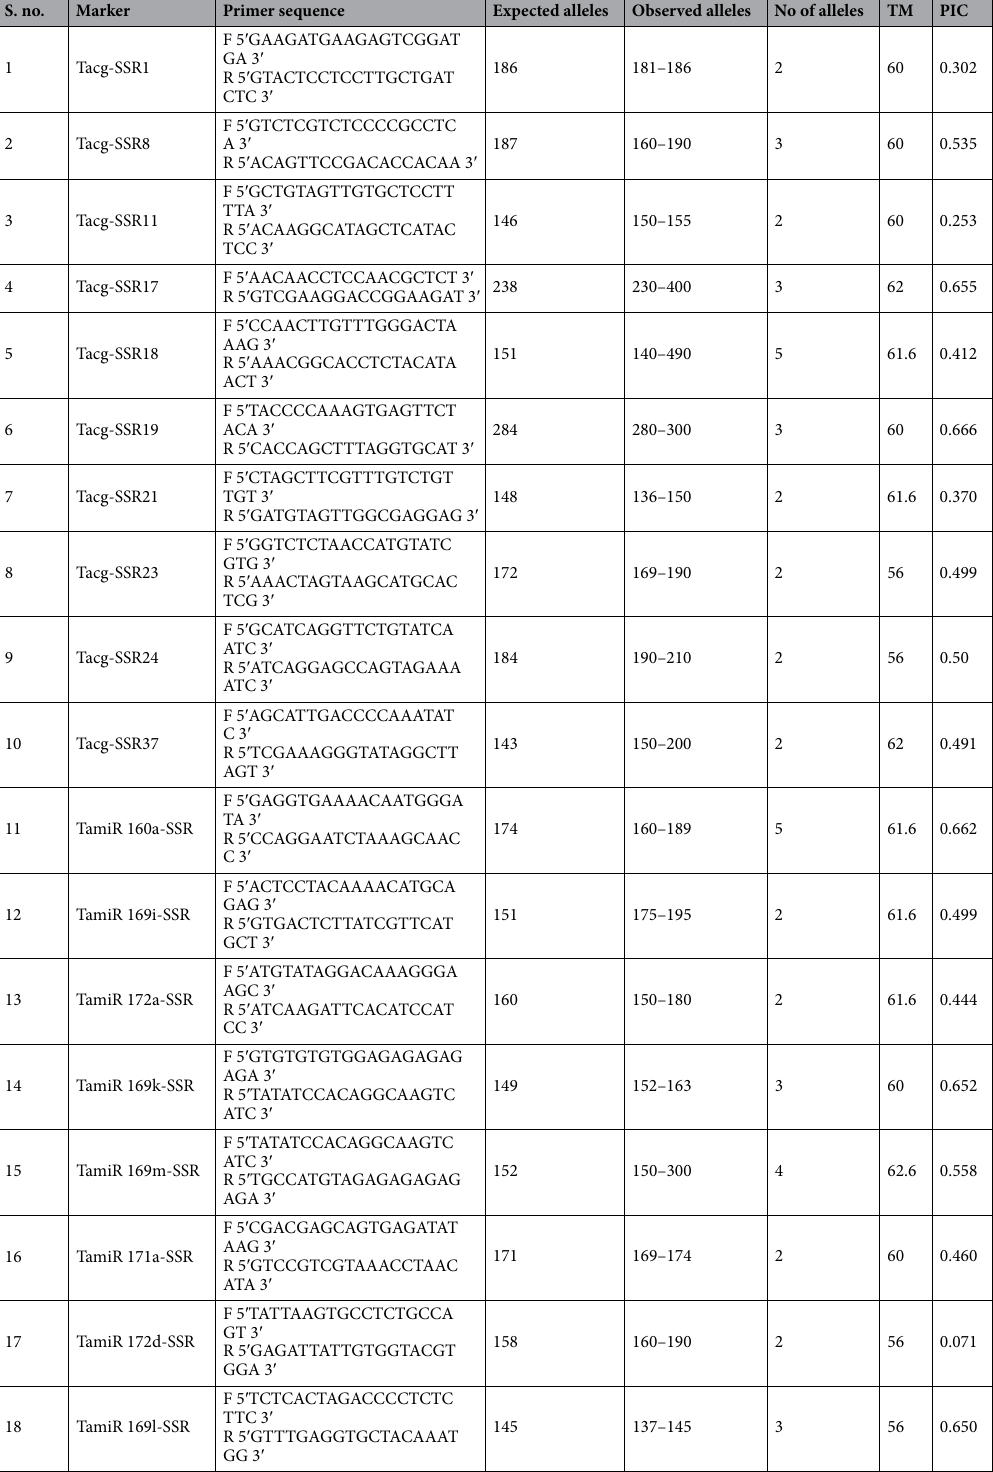
Table 2. Details of polymorphic Tacg-SSRs and TamiR-SSRs used in this